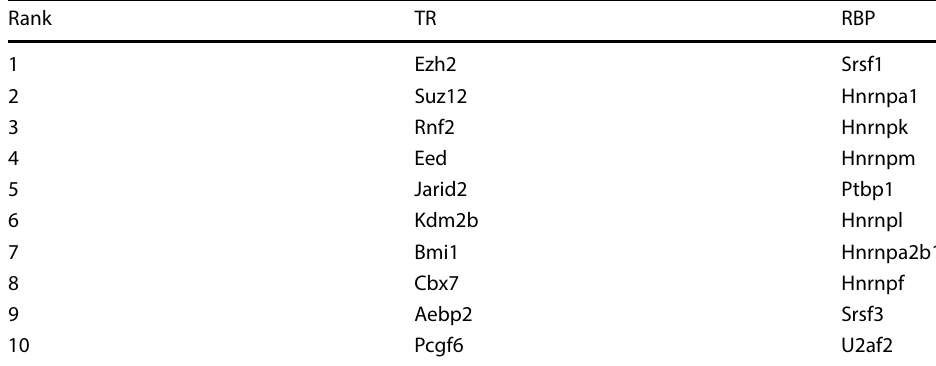
Table 1 Hub TRs and RBPs potentially influencing AHN